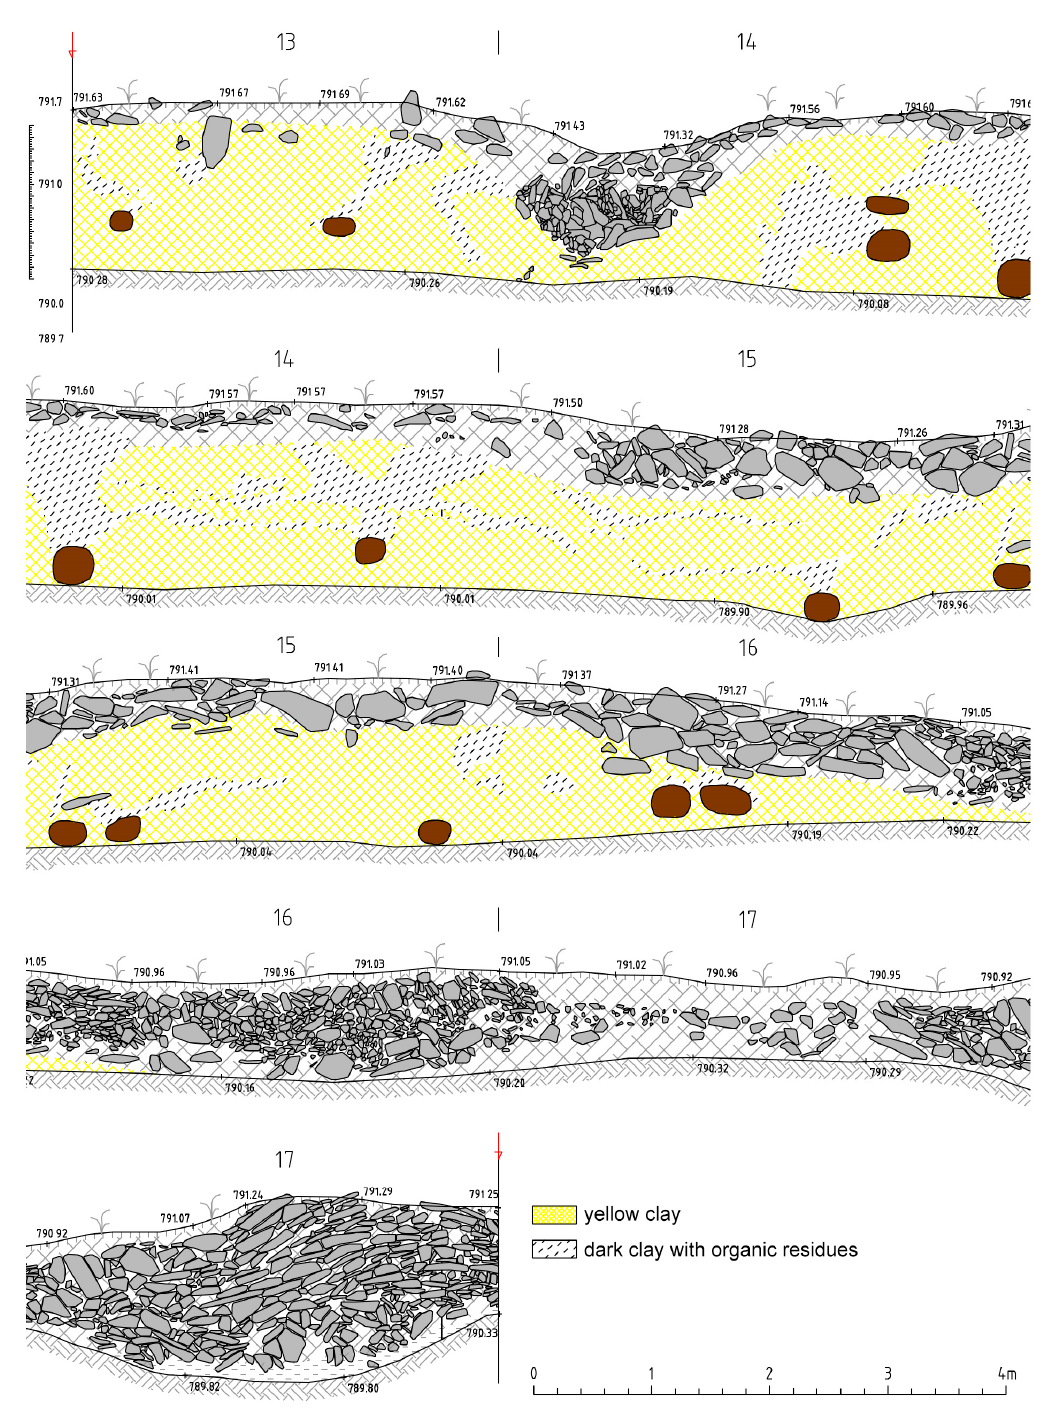
Figure 11. Partial profile E of the burial mound Tunnug 1, excavated and documented in 2019. A layer of stones is covering clay architecture built over a structure of larch logs dating to the 9th century BCE [18].